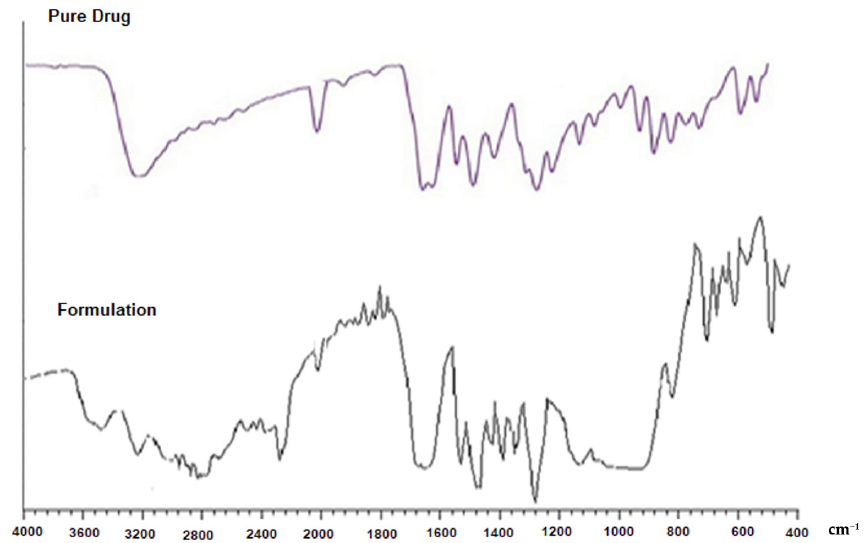
Figure 2. FTIR spectra of the Kaempferol (pure drug) and the prepared Kaempferol nanoparticle. Table 3. IR spectra of Kaempferol and DNP-7.